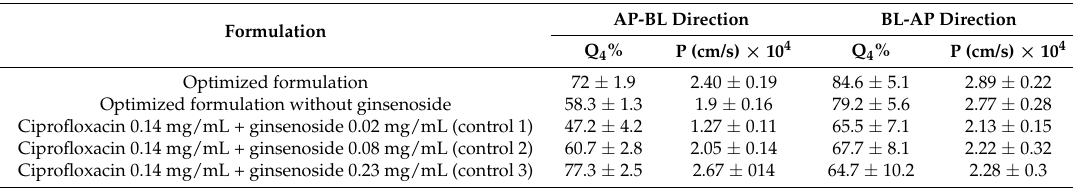
Table 4. Permeability parameters of ciprofloxacin through Caco-2 cells monolayer in AP-BL and BL-AP directions (mean ± SD, n =